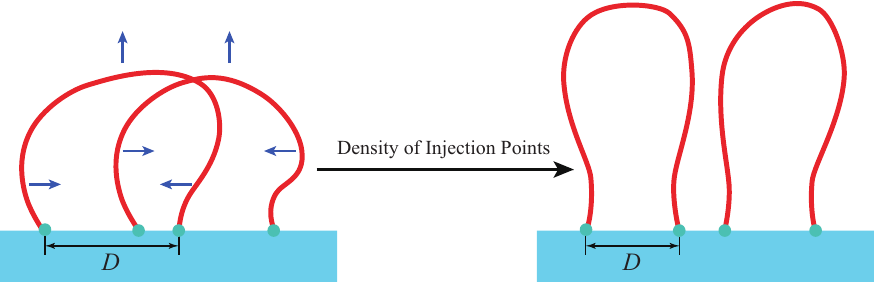
Figure 11. Schematic diagram of loop responding to the density of injection points. Two motion modes are presented: 1. the horizontal arrows represent the motion along the direction parallel to the lamellae edge, leading to the decreasing of (cid:104) D (cid:105) ; 2. the vertical arrows represent the motion along the direction of stems, leading to the increasing of (cid:104) H (cid:105)